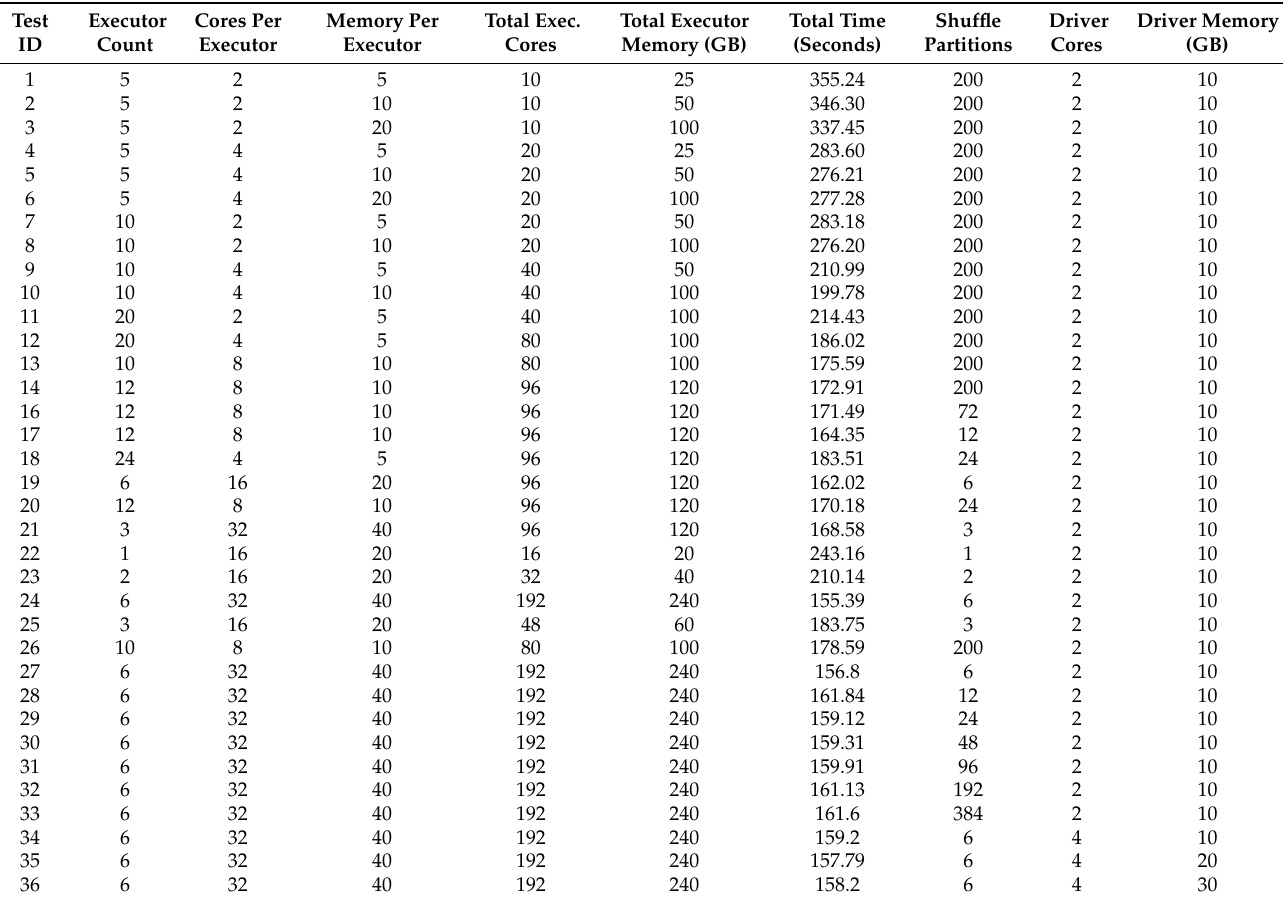
Table 16. Effect on total time with additional Spark configuration